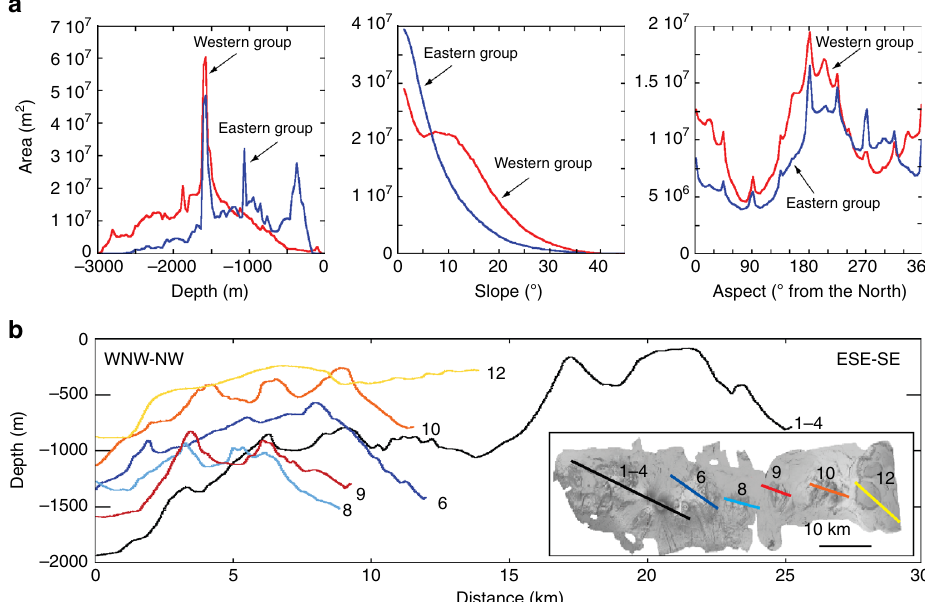
Fig. 3 Morphometry of the Palinuro STEP volcanic chain. a Depth vs. area, slope vs. area, and aspect vs. area plots of the STEP volcanic chain as calculated from the morphometric parameters of the DTM in Fig. 2a (see auxiliary material). b Bathymetric pro fi les of the volcanoes 1 – 4, 6, 8, 9, 10, and 12 (location in b